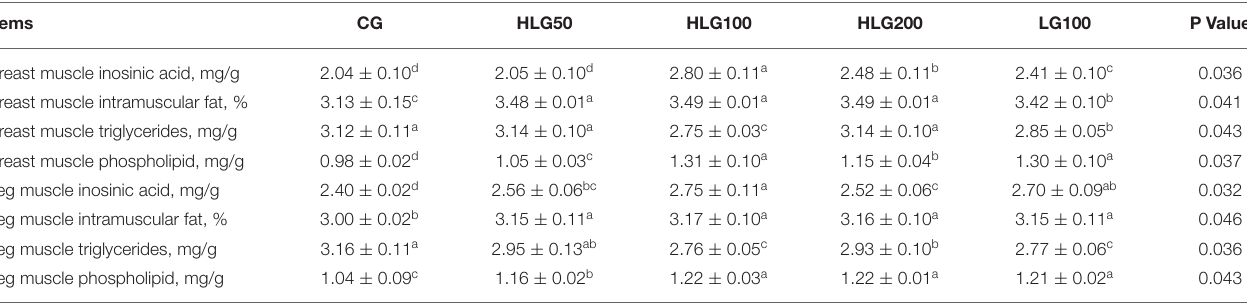
TABLE 10 | Effects of hydroxylated lecithin on muscle inosinic acid and other indicators of Jiangnan White goslings.